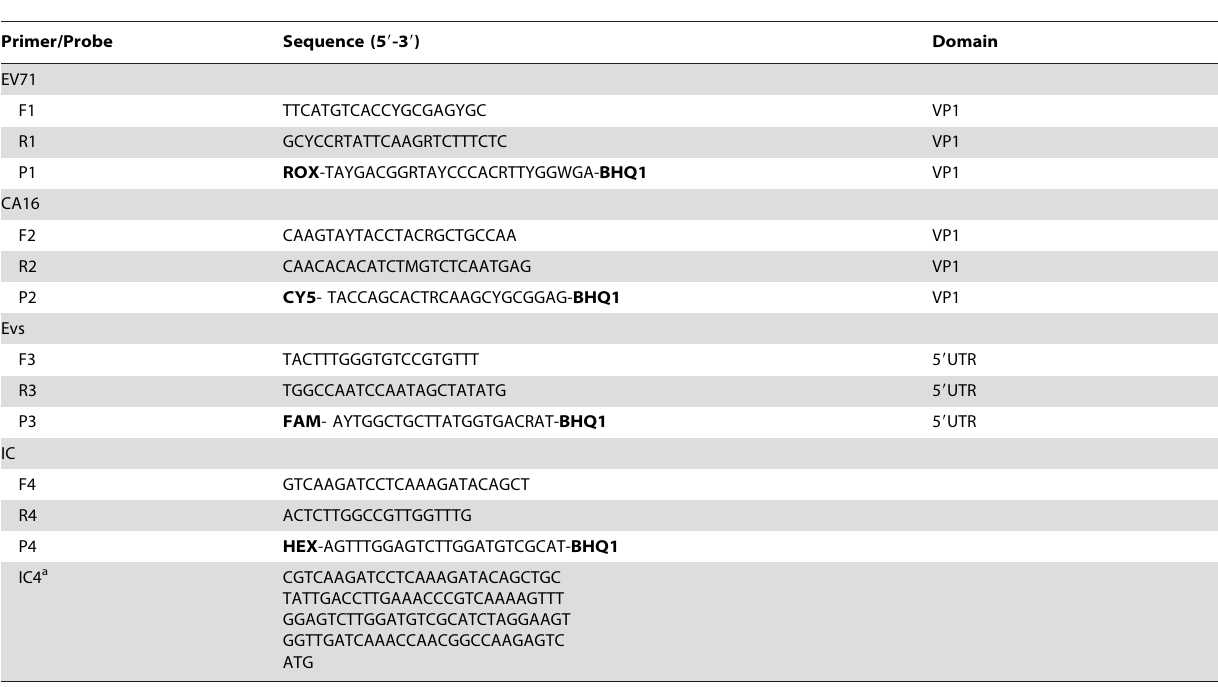
Table 1. Primers and probes designed for the specific amplification of EV71, CA16 and QEV.